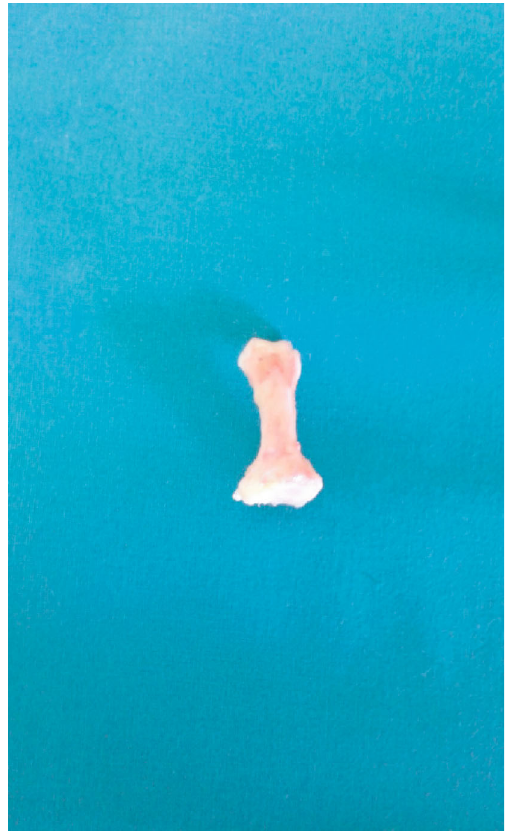
Figure 4: Photograph of the extirpated proximal phalanx of the second